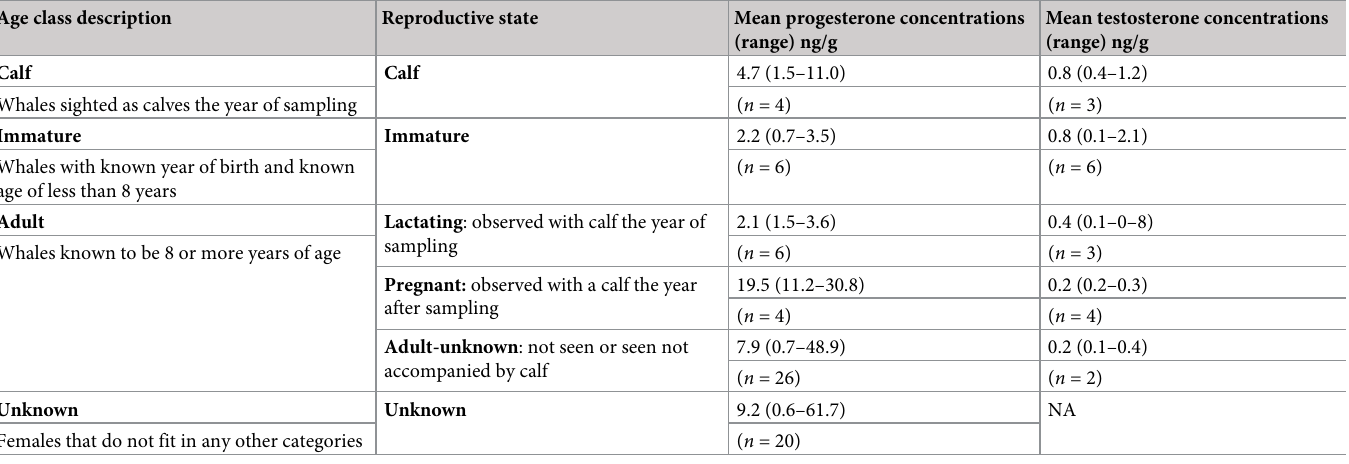
(Tables 1 and 2). We further sorted female gray whales by the following reproductive states: calves if sampled as such, immature if they had a known age less than 8 years old when sam- pled, pregnant if sighted with a calf the year after sampling and lactating if sighted in close association with a small whale noted as calf when sampled (Table 2). We considered as non- pregnant all females from the calf, immature and lactating groups. We classified as adult